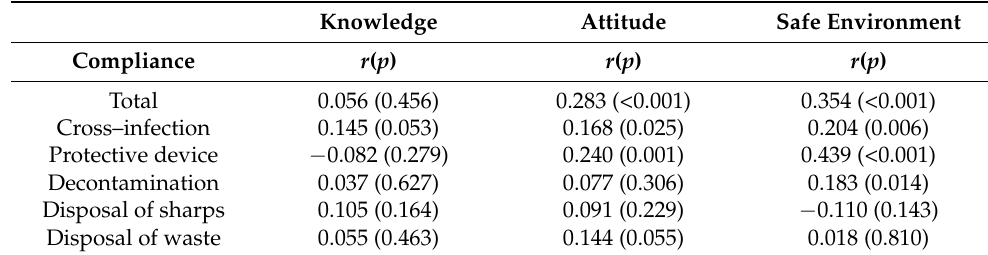
Table 5. Relationships between knowledge, attitude, safe environment, and IPC compliance ( n = 178).